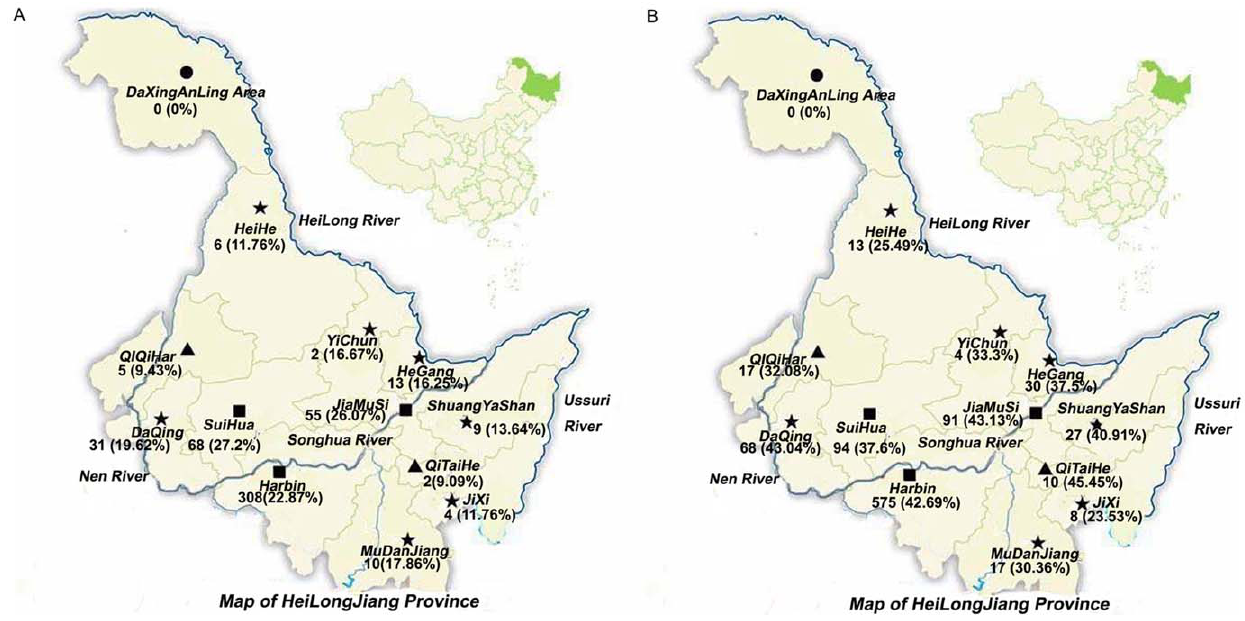
Figure 2. Regional distribution of Clonorchissinensis infection in Heilongjiang Province by Kato-Katz and ELISA examinations. A. by Kato-Katz B. by ELISA. doi:10.1371/journal.pone.0046977.g002 from 2001 to 2004 and did not find other intestinal trematode and